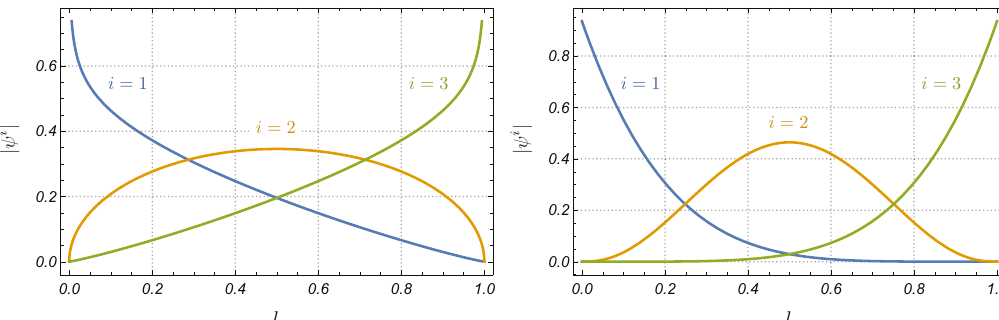
Figure 4 . Pro(cid:12)les of absolute values of spinor wavefunctions on the S 2 with two branes in terms of the modi(cid:12)ed l -coordinate. In the left and right panels, we set (cid:11) = 0 : 2, qM = 3 and (cid:11) = 0 : 8, qM = 11, respectively. It can be seen that di(cid:11)erent combinations of (cid:13)ux density and brane